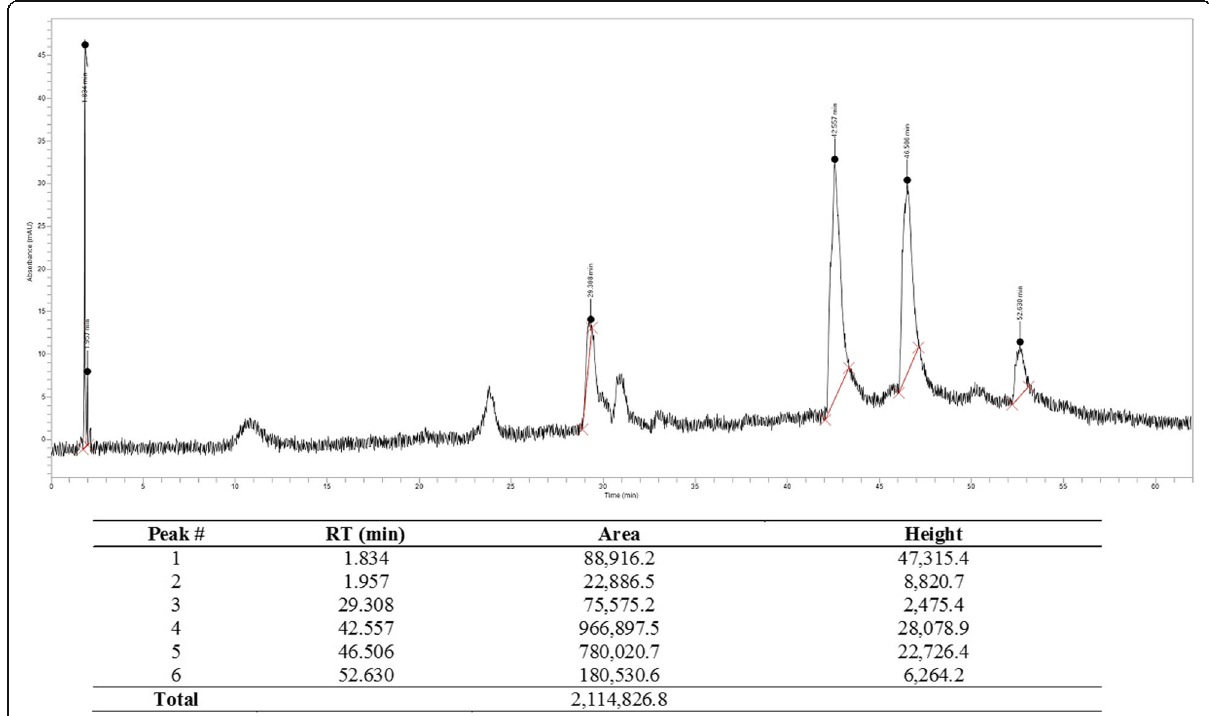
Fig. 1 HPLC chromatogram of SNE monitored at 315